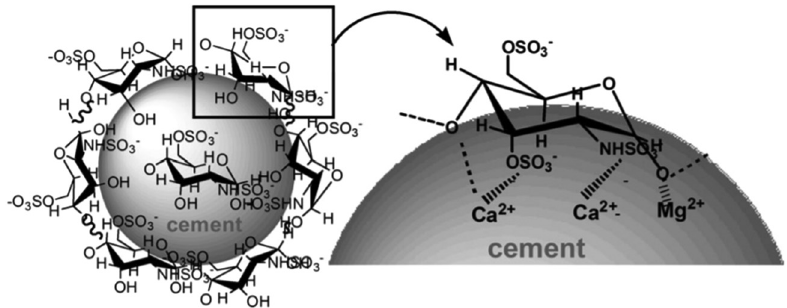
Figure 14: Schematic diagram of the absorption mechanism of SCS on cement particles surface, reprinted with permission from ref. [ 130 ] ; Copyright 2013, The American Ceramic